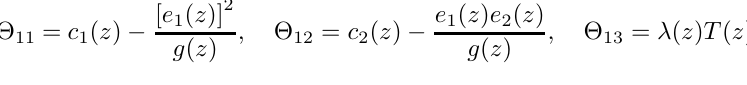
Fig. 24. Deflection of the mid-plane for the simply supported FGPM cylindrical shell imposed by a cosine distributed load, when t = 0 . 005 .